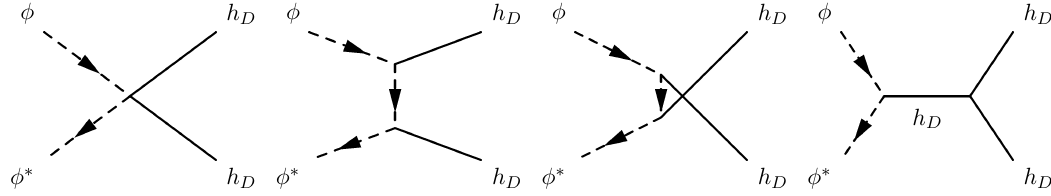
✁ Figure 4. The Feynman diagrams which contribute to the φ